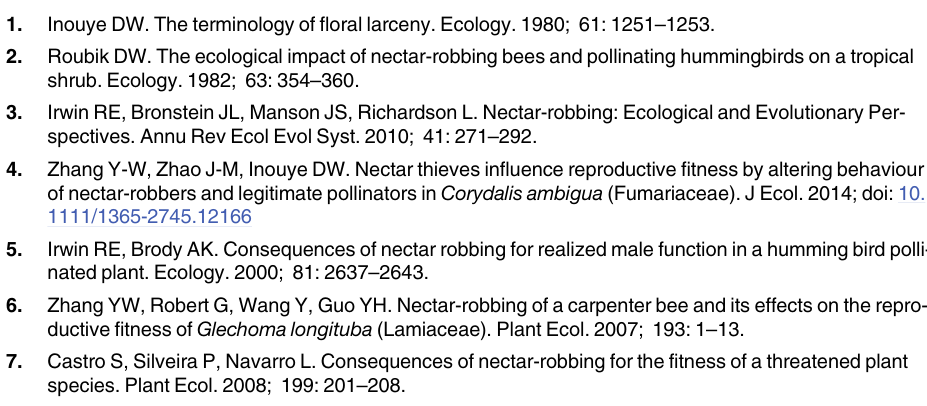
S1 Table. Mean flower visits with fluorescent dye in the stigma of each flower for robbed and unrobbed Four Directional Plots (FDP). S2 Table. Data shows that impact of nectar robbing on fruit set based on number of flowers and inflorescences, and seed set based on number of fruits in robbed and unrobbed FDP, during 2005 and